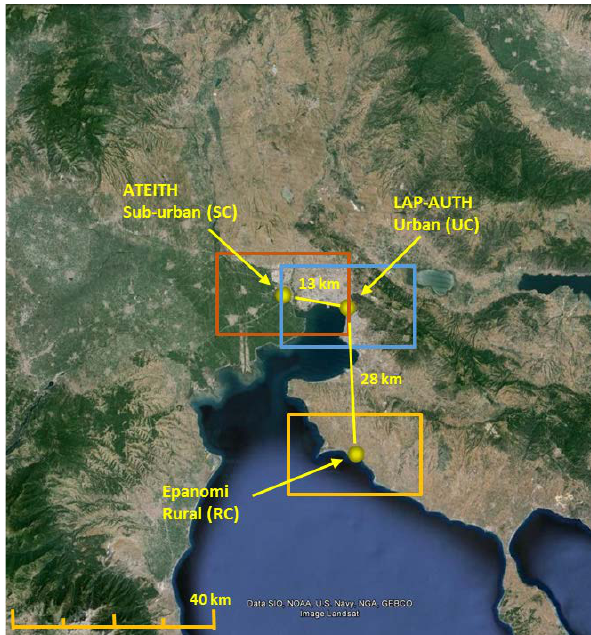
Figure 1. Map of the greater Thessaloniki area with the three sites of measurements: urban conditions (UCs) (blue), suburban condi- tions (SCs) (red) and rural conditions (RCs) (yellow). The rectangu- lar outlines represent the area covered by the nadir pixel size of OMI centered at each location (image courtesy of Google Earth NASA